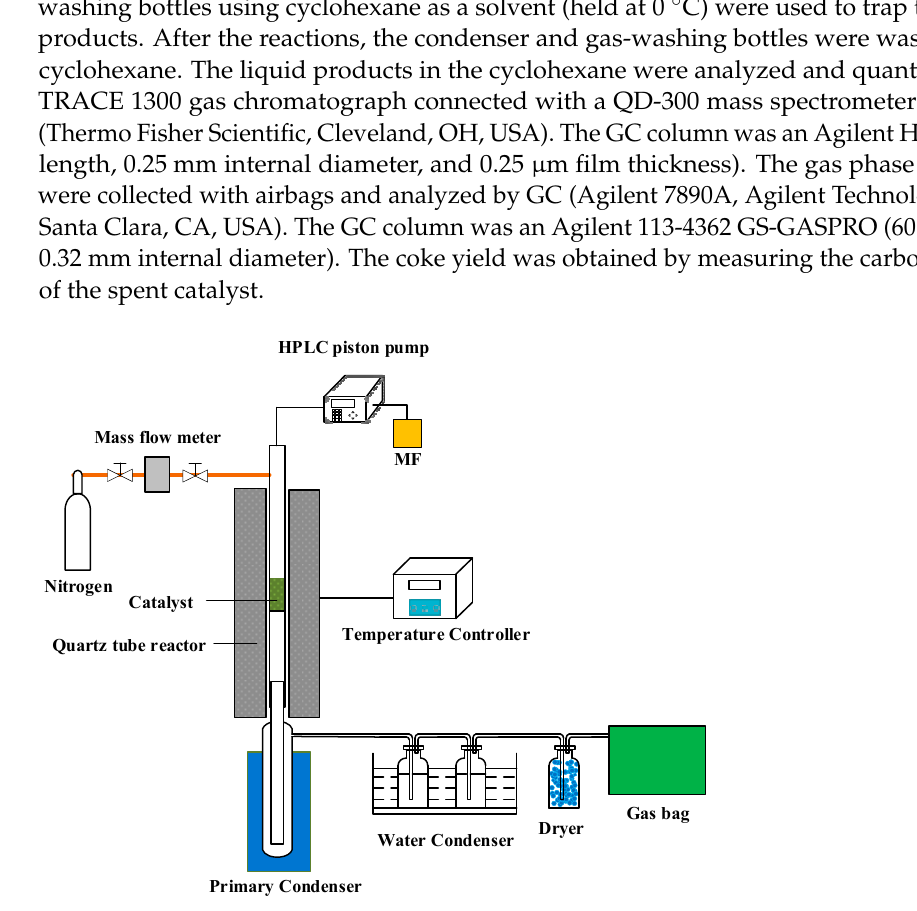
Figure 6. The schematic diagram of the fixed bed for CFP of MF.